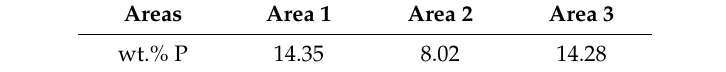
Table 2. wt.% P of NiP / 20 SiC coating, on the nodule surface and nodule boundary. Areas